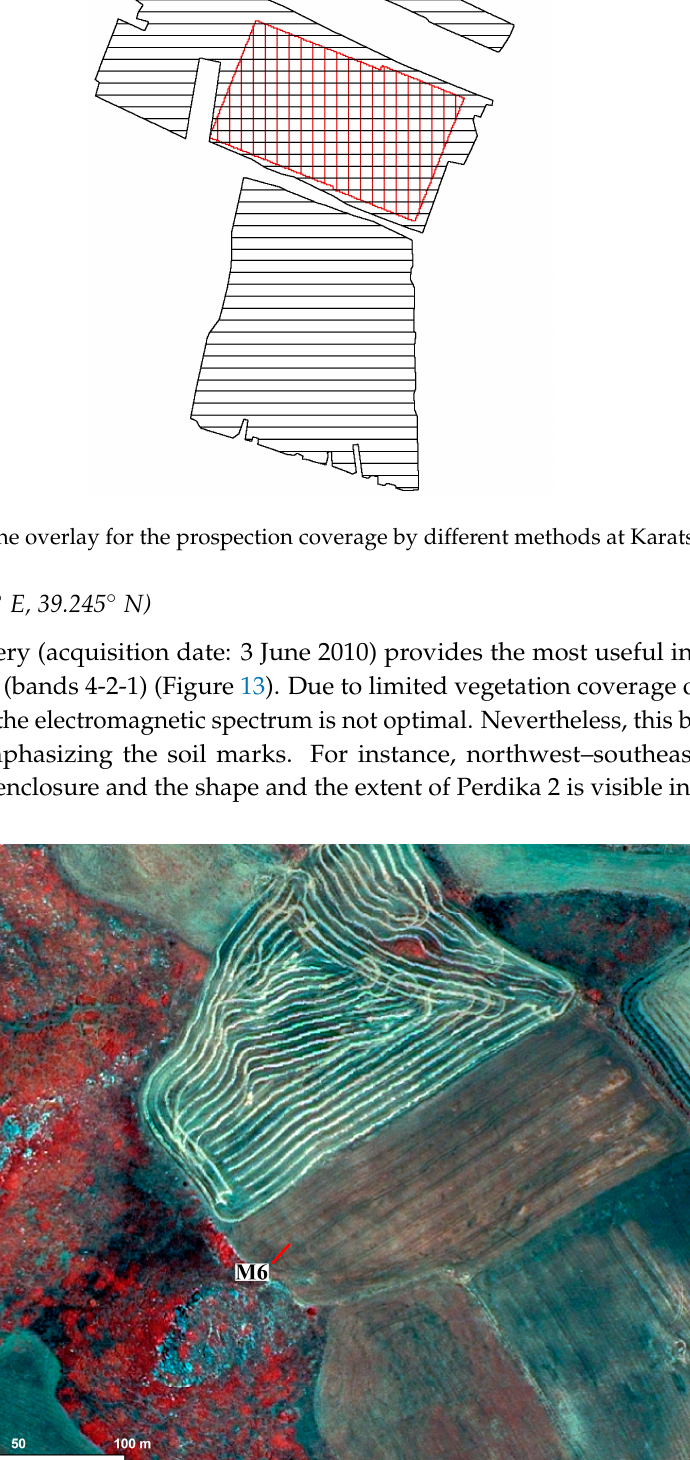
Figure 11. Magnetic susceptibility ( a ); and electromagnetic conductivity ( b ) results from Karatsantagli.